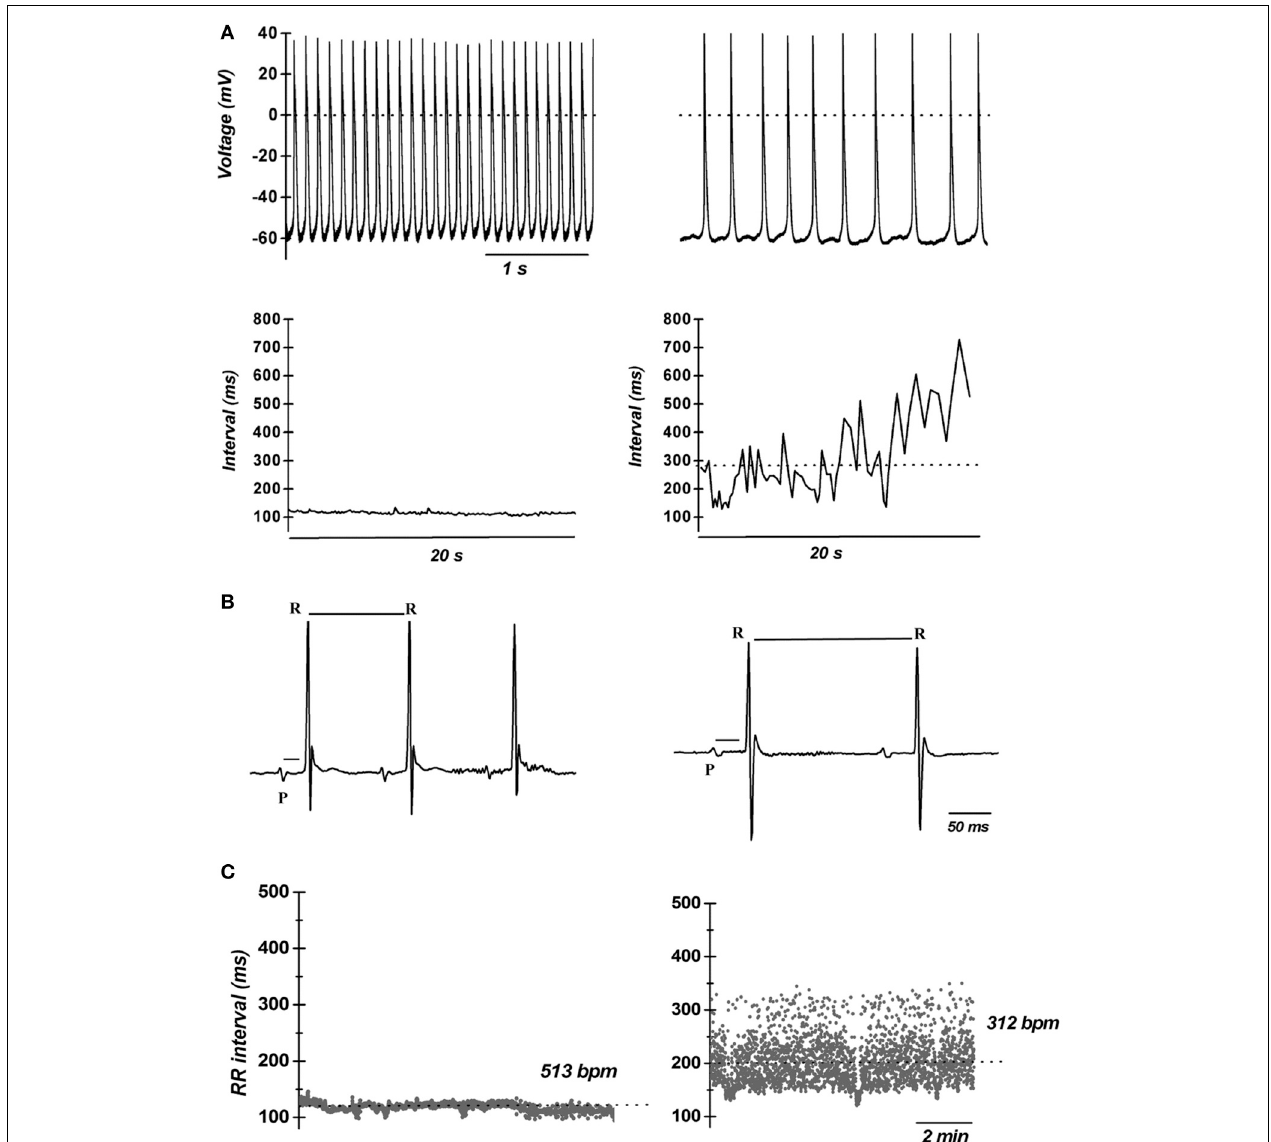
FIGURE 1 | Importance of L-type VGCCs in cardiac automaticity. (A) Representative recordings of consecutive action potentials recorded in pacemaker cells from wild-type (top left panel) and Ca v 1.3 − / − mice (top right panel). Cellular arrhythmia is evident as irregular cycle length duration in Ca v 1.3 − / − cells (bottom right panel) compared with wild-type cells (bottom left panel). Dotted lines indicate the zero voltage level (Data from Mangoni et al., 2003). (B) Telemetric ECGs showing prolongation of RR interval PQ